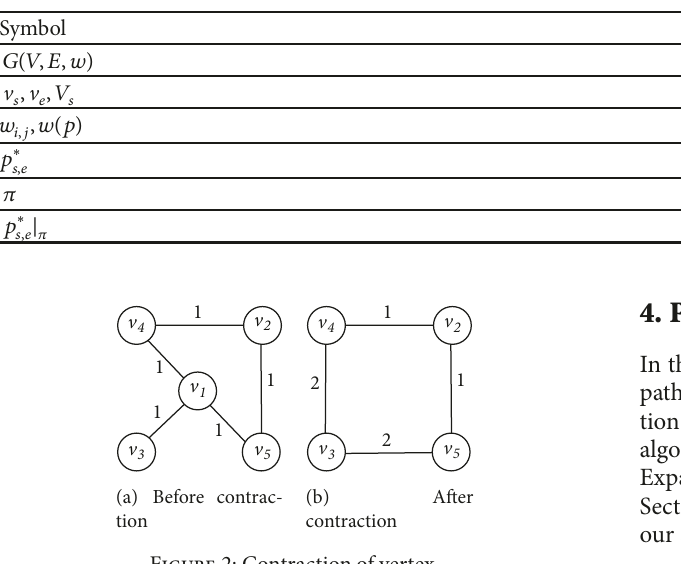
Table 1: List of notations.